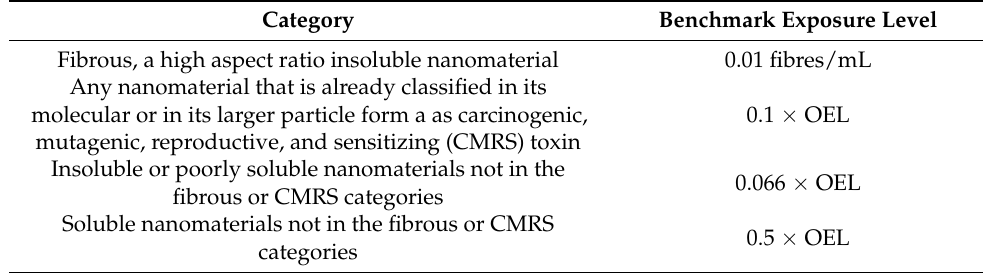
Table 4. OELs for nanomaterial